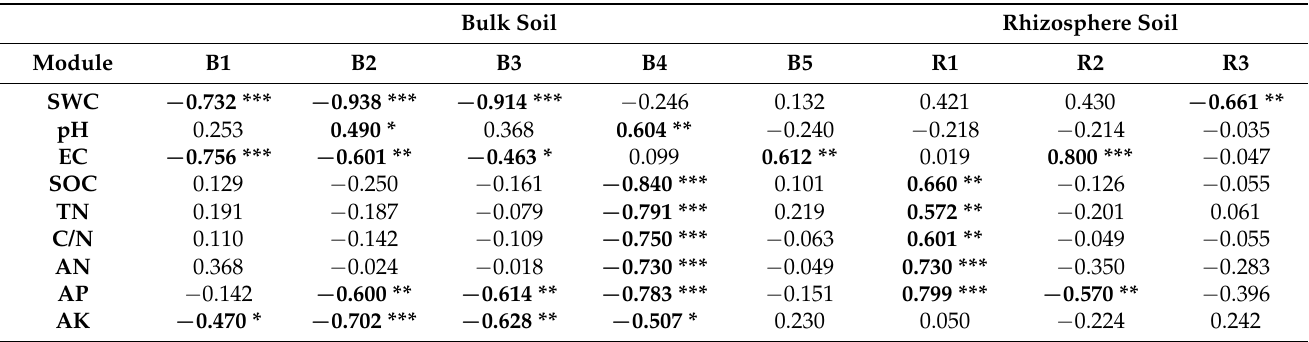
Figure 6. The module eigengenes of fungal networks in the rhizosphere ( A ) and bulk soil ( B ) of the four selected plant species. The upper part indicates the results of hierarchical clustering according to Pearson’s correlation analyses conducted among module eigengenes, and the heatmap shows the correlation coefficient (r) value. The percentage of the total variance explained by the module eigengenes is shown on the left side of the heatmaps. Modules larger than five nodes are presented and labelled as ‘R’ (rhizosphere soil) and ‘B’ (bulk soil). Table 3. Correlation coefficients between module eigengenes and soil properties in the bulk and rhizosphere soils of the four selected